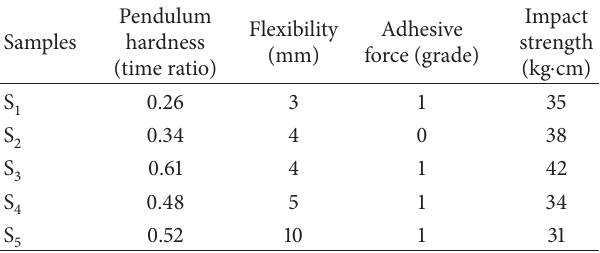
Figure 8: TG curves of CF, UVCF, and cured film of 𝑆 3 . Table 3: Mechanical properties of cured UVCF